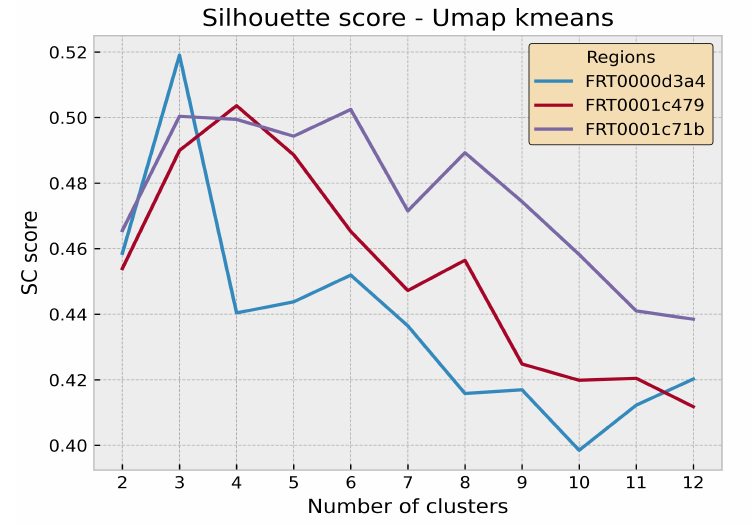
Figure 4. Silhouette Score UMAP + K-Means as a function of the number of clusters for all three datasets.